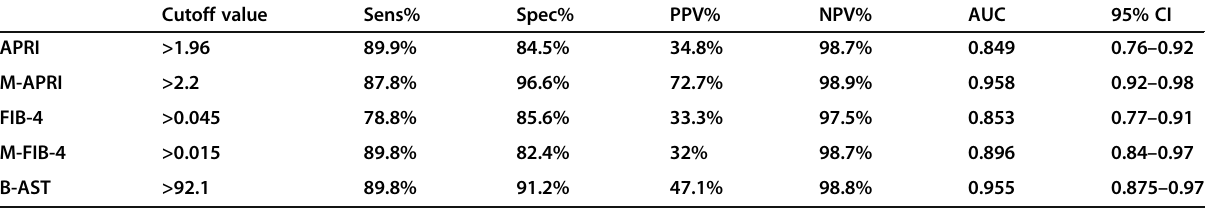
Table 6 Performance of the studied non-invasive biomarkers in the detection of advanced liver fibrosis (F3 – F4) in the studied group Cutoff value